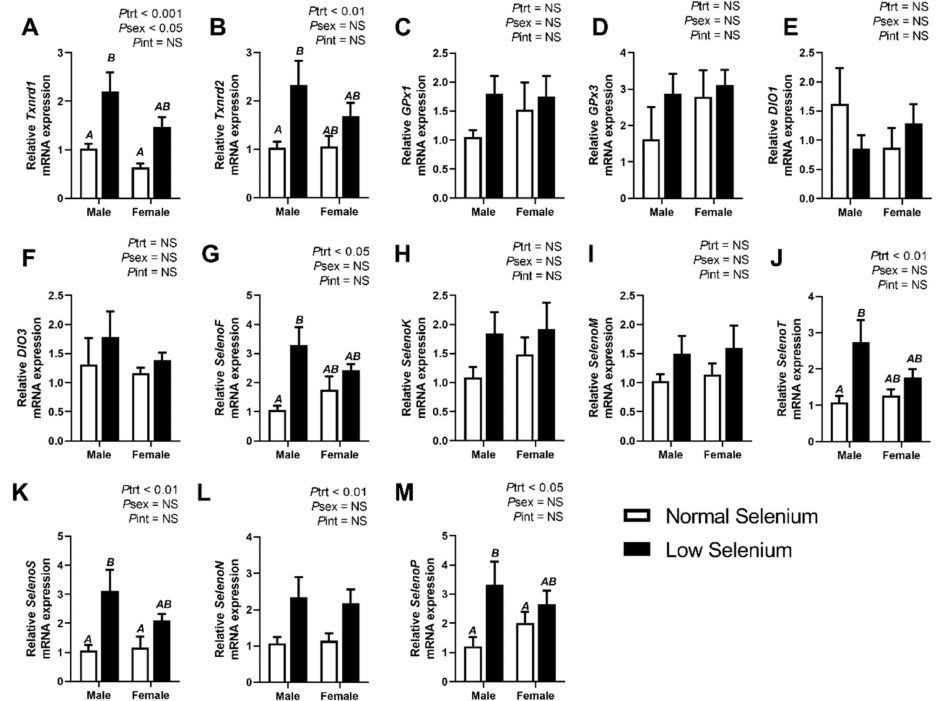
Figure 1. E ff ects of selenium deficiency on selenoprotein expression in fetal liver at E18.5. Expression in male and female fetal livers, at E18.5, of; ( A ) thioredoxin reductase 1, ( B ) thioredoxin reductase 2, ( C ) glutathione peroxidase 1, ( D ) glutathione peroxidase 3, ( E ) deiodinase 1, ( F ) deiodinase 3, ( G ) selenoprotein F, ( H ) selenoprotein K, ( I ) selenoprotein M, ( J ) selenoprotein T, ( K ) selenoprotein S. ( L ) selenoprotein N and ( M ) selenoprotein P. Data are mean ± SEM and analysed by two-way ANOVA with treatment ( P trt ) and sex ( P sex ) as major factors. P int represents the interaction between treatment and sex. Significance was determined as p < 0.05. If a major e ff ect of treatment, sex or an interaction between treatment and sex was identified, then a Sidak posthoc test was performed. Significant di ff erences between groups as detected by posthoc analysis are denoted by di ff erent letters where “A” is di ff erent from “B”, but not “AB”. The groups are Normal male, n = 6 (6 animals from 6 separate litters); Low male, n = 6 (from 6 separate litters); Normal female, n = 6 (from 6 separate litters); Low female, n = 6 (from 6 separate